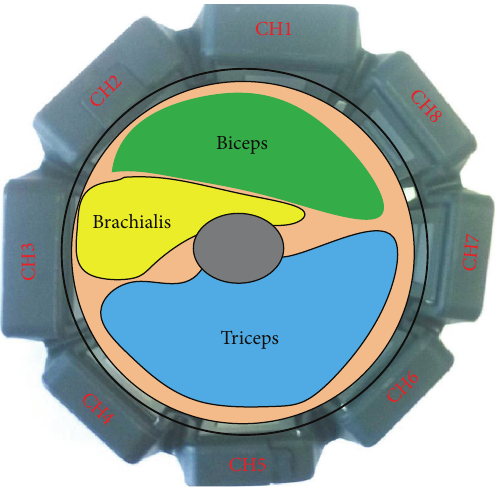
Figure 9: Muscles, number, and positions of electrodes involved in the elbow joint stiffness estimation [46].